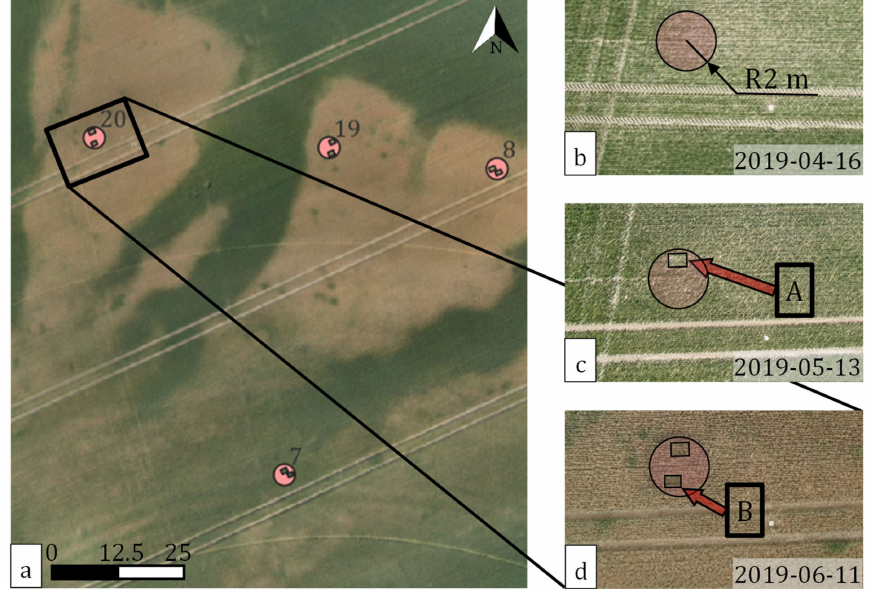
Figure 4. Illustration of buffer zones used in this study. The June’s buffer zone was marked in pink ( a , d ). The April buffer consists of a circle with a radius of 2 m ( b ). Central points are located by GNSS. Because each ground measurement involves sampling of biomass, the ( c ) May and ( d ) June buffers need to remove the subtracted biomass area according to the actual location. The squares represent the cut biomass in April and May, which are marked as A and B,